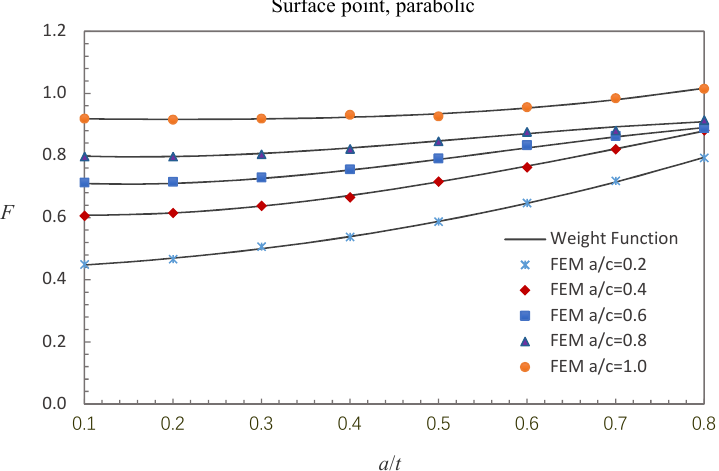
Figure 5. Comparison of weight function and FE results in this study with parabolic stress distribution (surface point).